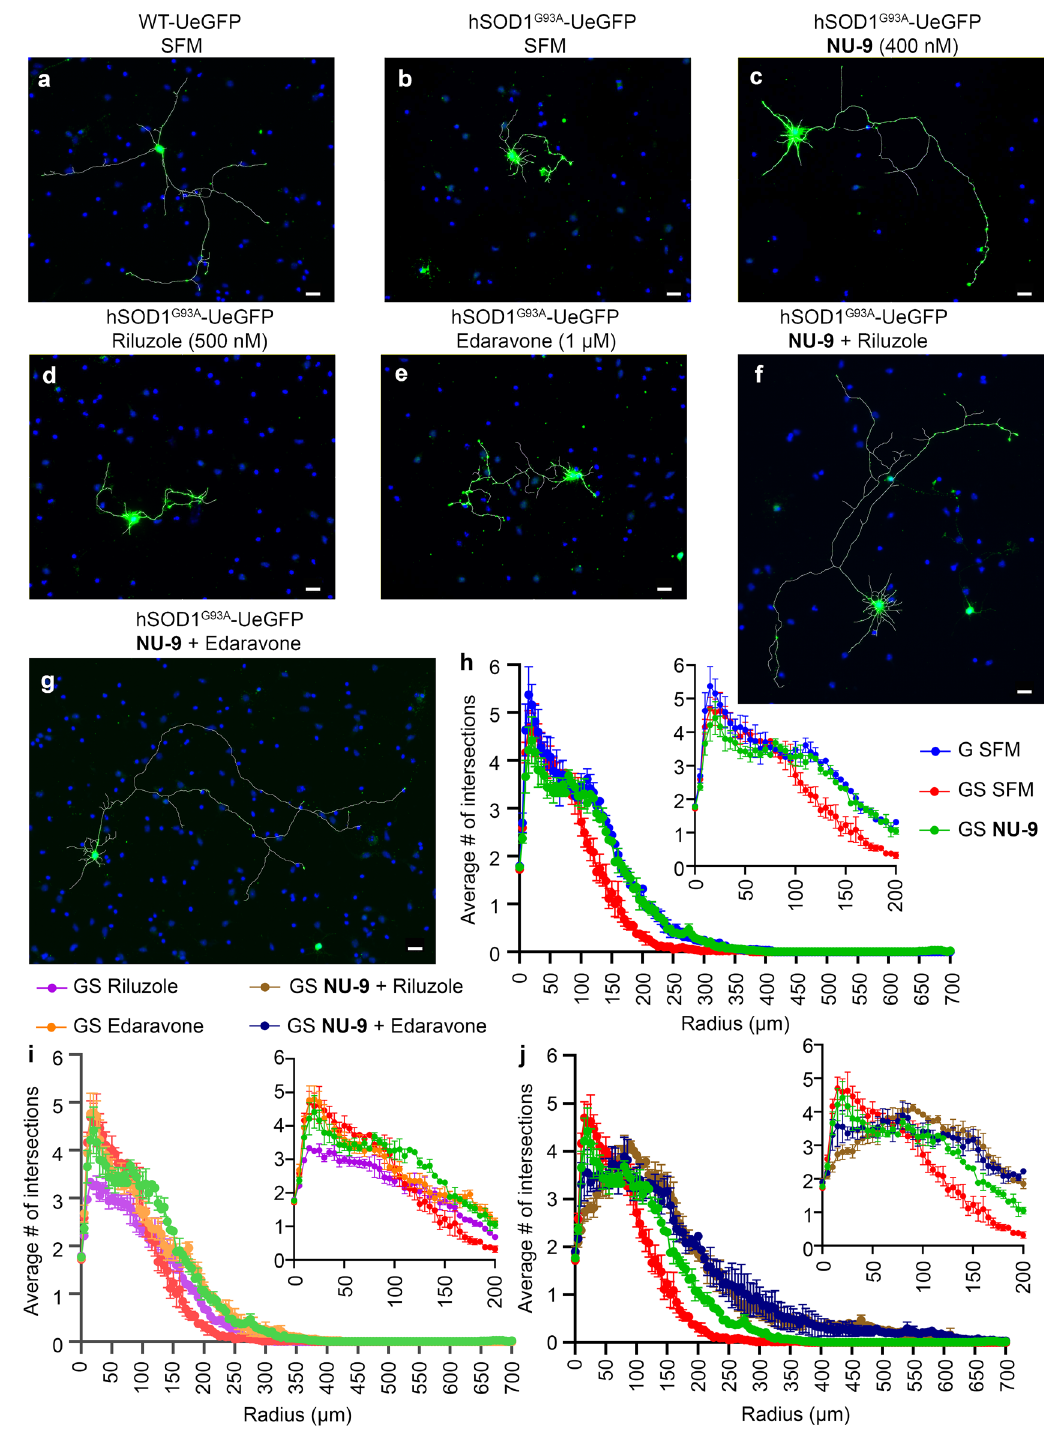
Figure 4. Sholl analysis of UMNs from WT-UeGFP and hSOD1 G93A -UeGFP mice with or without various drug treatments. ( a ) Representative images of UMNs in dissociated cell cultures of motor cortex isolated from WT-UeGFP, hSOD1 G93A -UeGFP mice treated with SFM ( b ), with 400 nM of NU-9 ( c ), with 500 nM riluzole, ( d ), 1 µM edaravone ( e ), combination of NU-9 and riluzole ( f ), combination of NU-9 and edaravone ( g ) for 3 days in vitro. ( h ) Sholl analyses of WT-UeGFP UMN treated with SFM (blue), hSOD1 G93A -UeGFP UMN treated with SFM (red), and NU-9 (green). ( i ) Sholl analyses of hSOD1 G93A -UeGFP UMN treated with NU-9 (green), edaravone (orange), riluzole (purple), and SFM (red). ( j ) Sholl analyses of hSOD1 G93A -UeGFP UMN treated with NU-9 and edaravone (dark blue), NU-9 and riluzole (brown), NU-9 alone (green), and SFM (red). 0–200 µm radius range is enlarged in the inset for clarification. Scale bar = 20 µm, n = 3 biological replicates. SFM = serum free medium; G = WT-UeGFP; GS = hSOD1 G93A